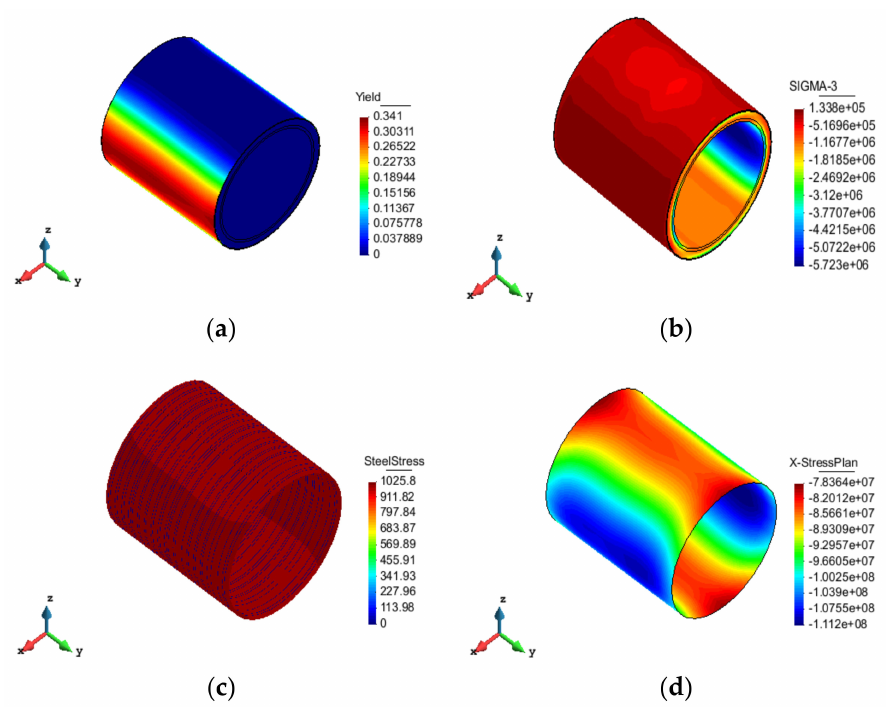
Figure 16. Nephogram of case 8: ( a ) damage, ( b ) 3rd principal stress, ( c ) wire stress, ( d ) cylinder